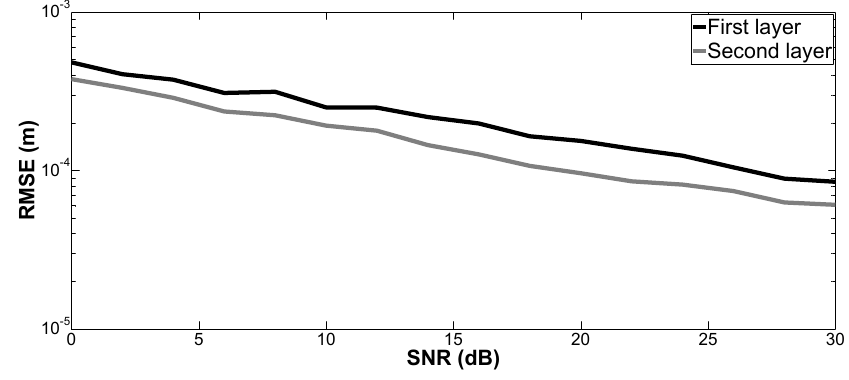
Figure 8. RMSE on the estimated thicknesses of the first and second layers: H 1 and H 2 versus SNR.